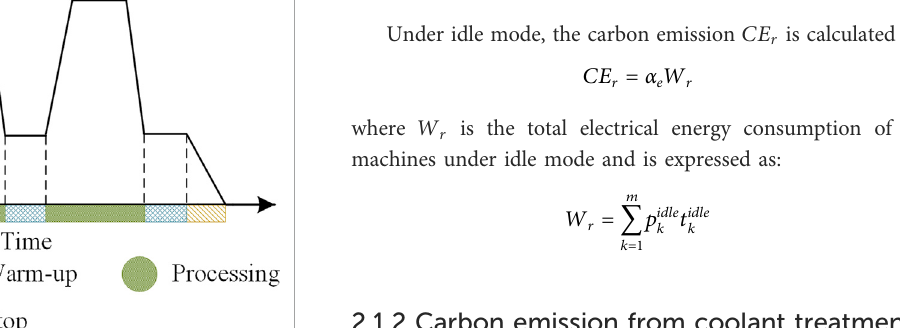
FIGURE 1 Power variation of fi ve machine working